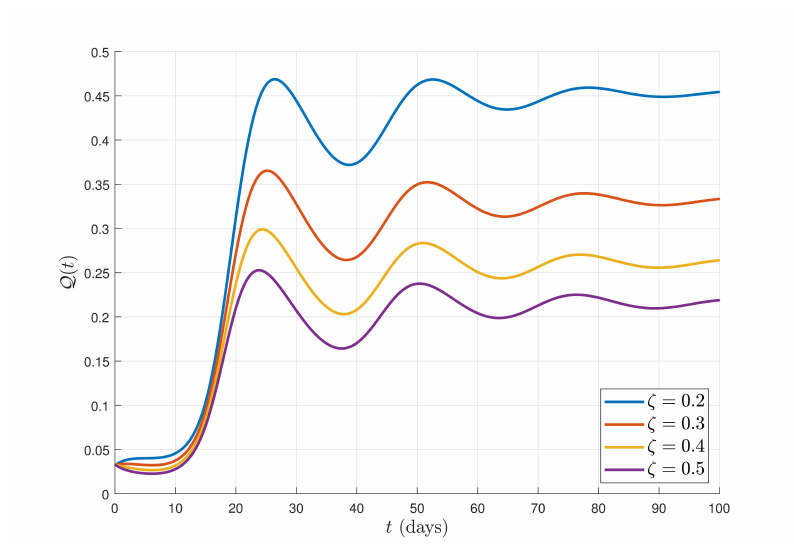
Figure 14. Effects of contact rates on state functions: Q ( t ) versus ζ